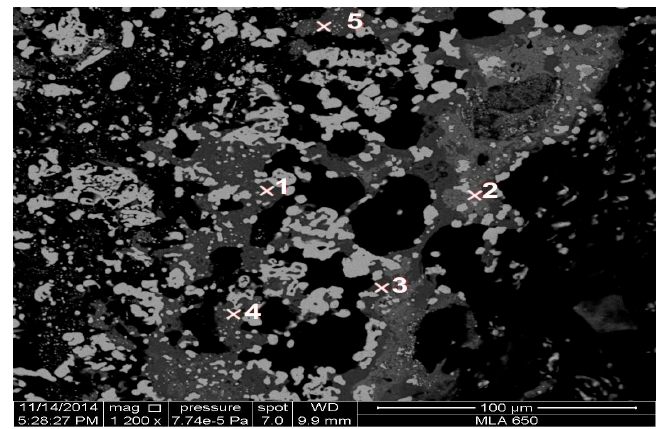
Figure 5. SEM-image of the reduced cement-bonded brex. 1, 3, 4—binary metasilicates; 2—silica containing calcium ferrite; 5—dicalcium ferrite.